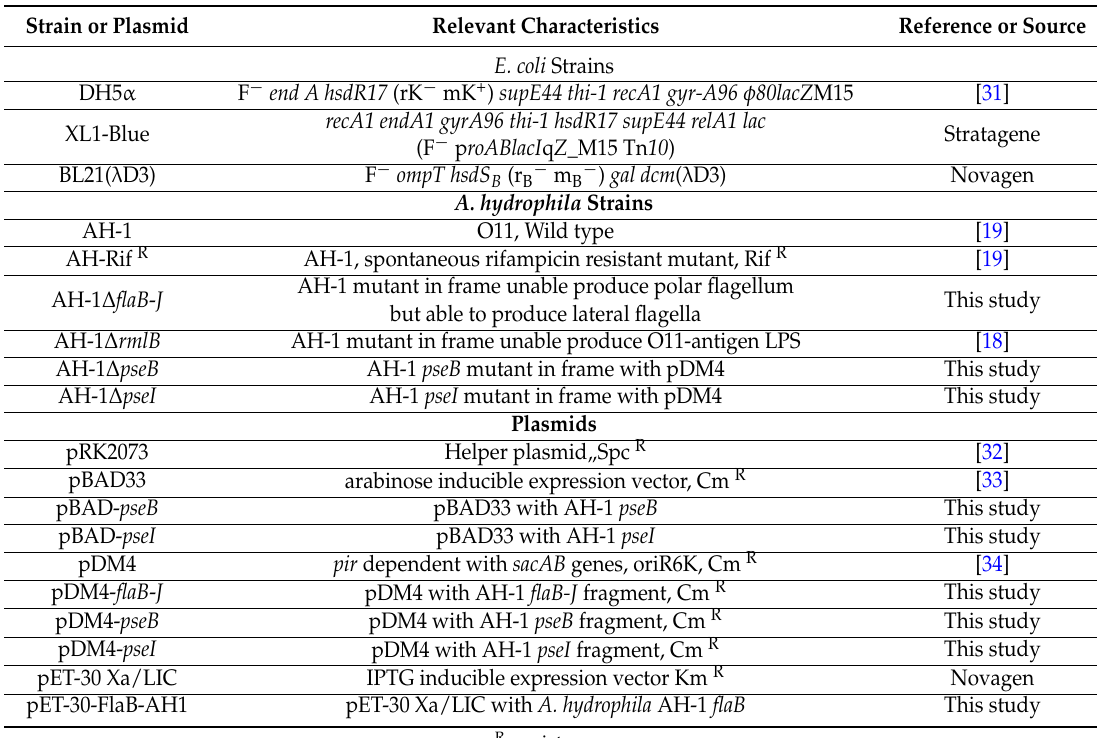
Table 3. Bacterial strains and plasmids